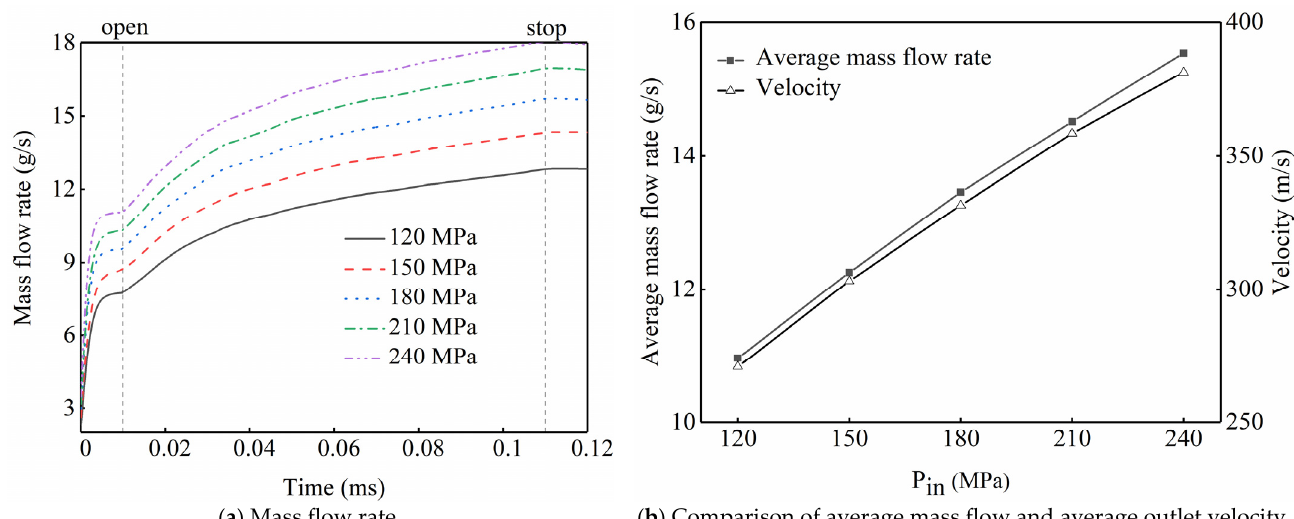
Figure 12. The effect of rail pressure on the flow characteristics of control valves.